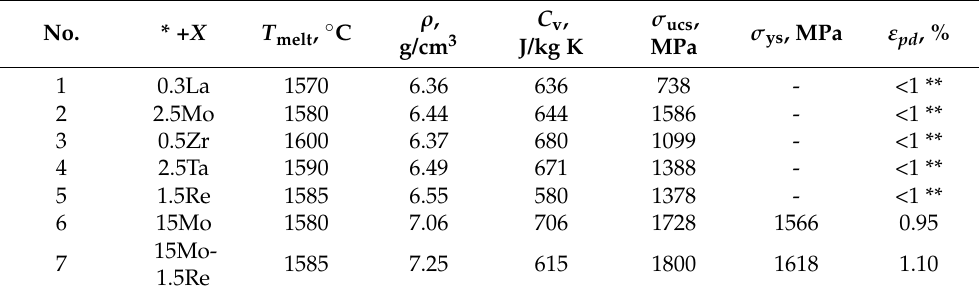
Table 9. Properties of the as-cast SHS alloys NiAl–Cr–Co–( X ), where X = La, Mo, Zr, Ta, and Re.